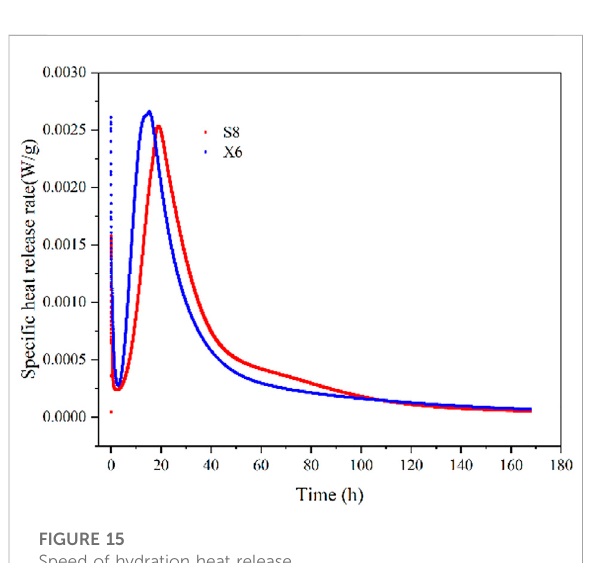
FIGURE 16 Total hydration heat